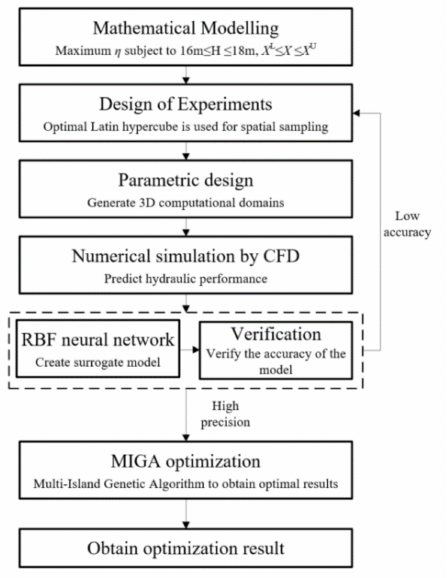
Figure 4. Procedure of the optimization